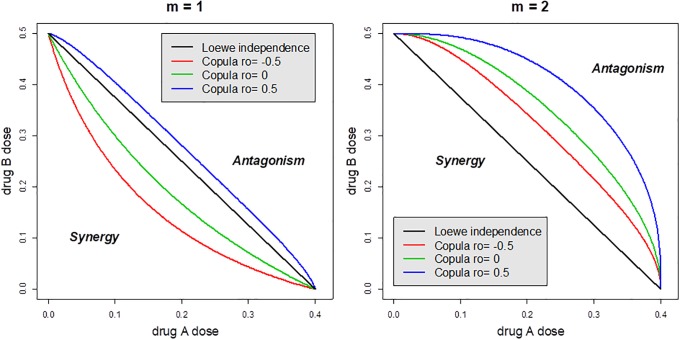
Illustration of the two-drug copula mortality function using EC50 contours.When drugs have moderate effect on mortality (m = 1) synergy will be underestimated by the Loewe approach and overestimated if drugs have a strong effect (m = 2).